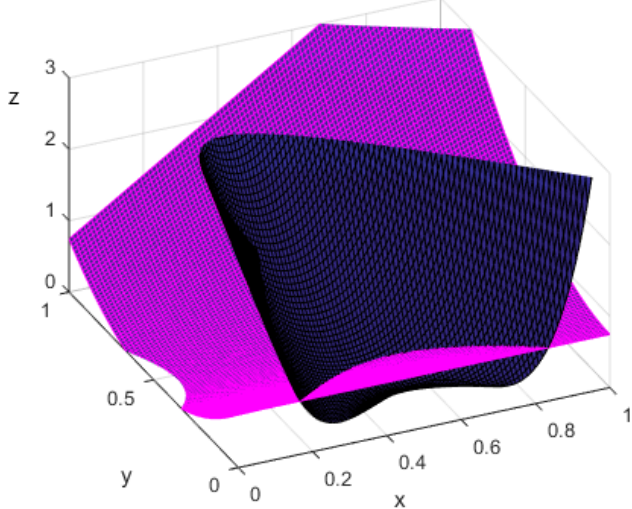
Figure A2. Curve τ as intersection of the two surfaces in the strategy